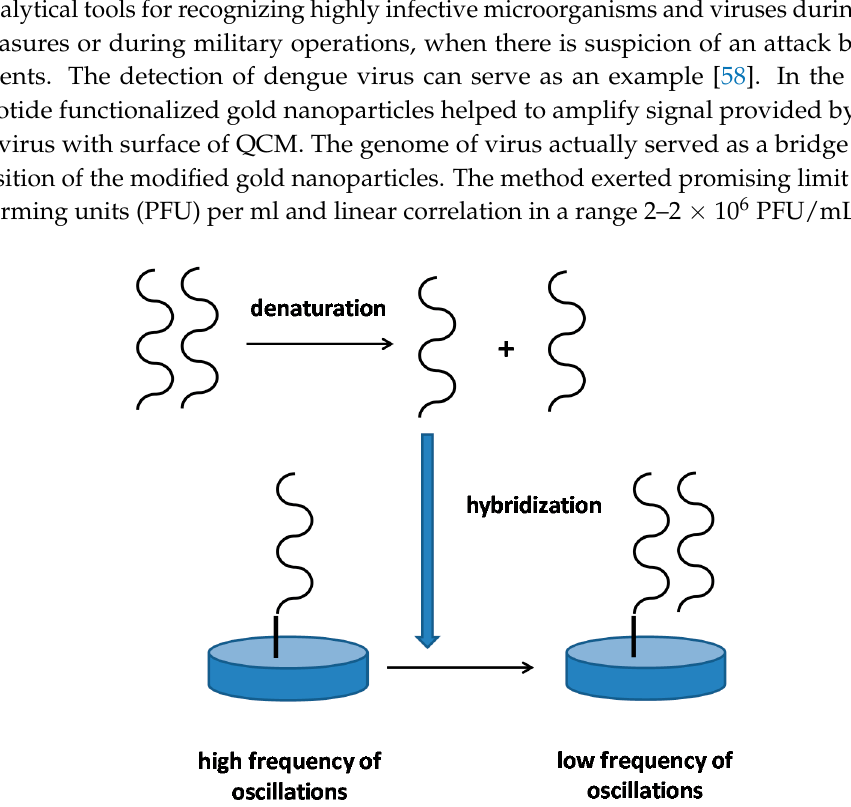
Figure 5. Principle of a DNA piezoelectric biosensor. The picture represents an idealized biosensor, real biosensors can be modified in their principle. In the first step, double stranded DNA in a sample is denatured by, for example, heat. In the second step, single stranded DNA hybridizes with complementary DNA strand immobilized on a piezoelectric sensor. The hybridization results in decrease of oscillation frequency.